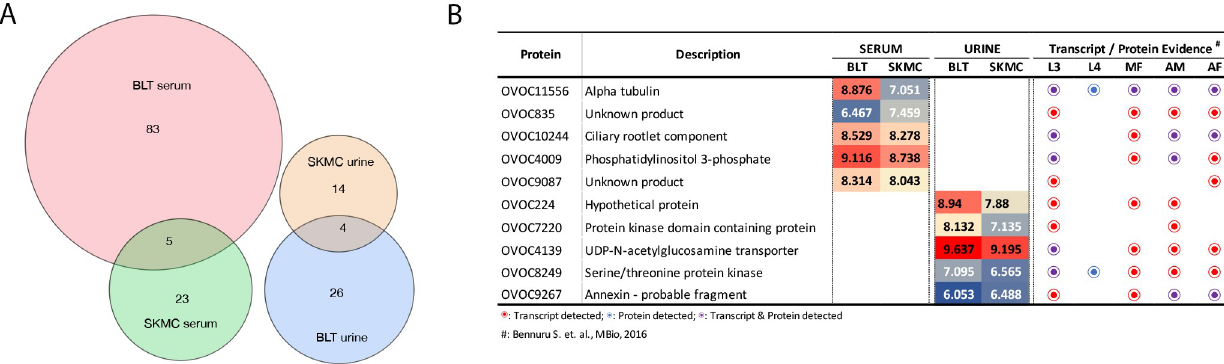
Fig 4. Proteomic identification in serum and urine of infected mice. A) Proportional venn diagrams showing the distribution of O . volvulus -proteins in the serum and urine of BLT (8-weeks) and HuSkMc (12-weeks) mice infected with O . volvulus L3. B) Proteins identified commonly in serum and urine shown in A. The buttons indicate evidence of the protein as transcript only (red), protein only (blue) or both transcript and protein (purple), across the